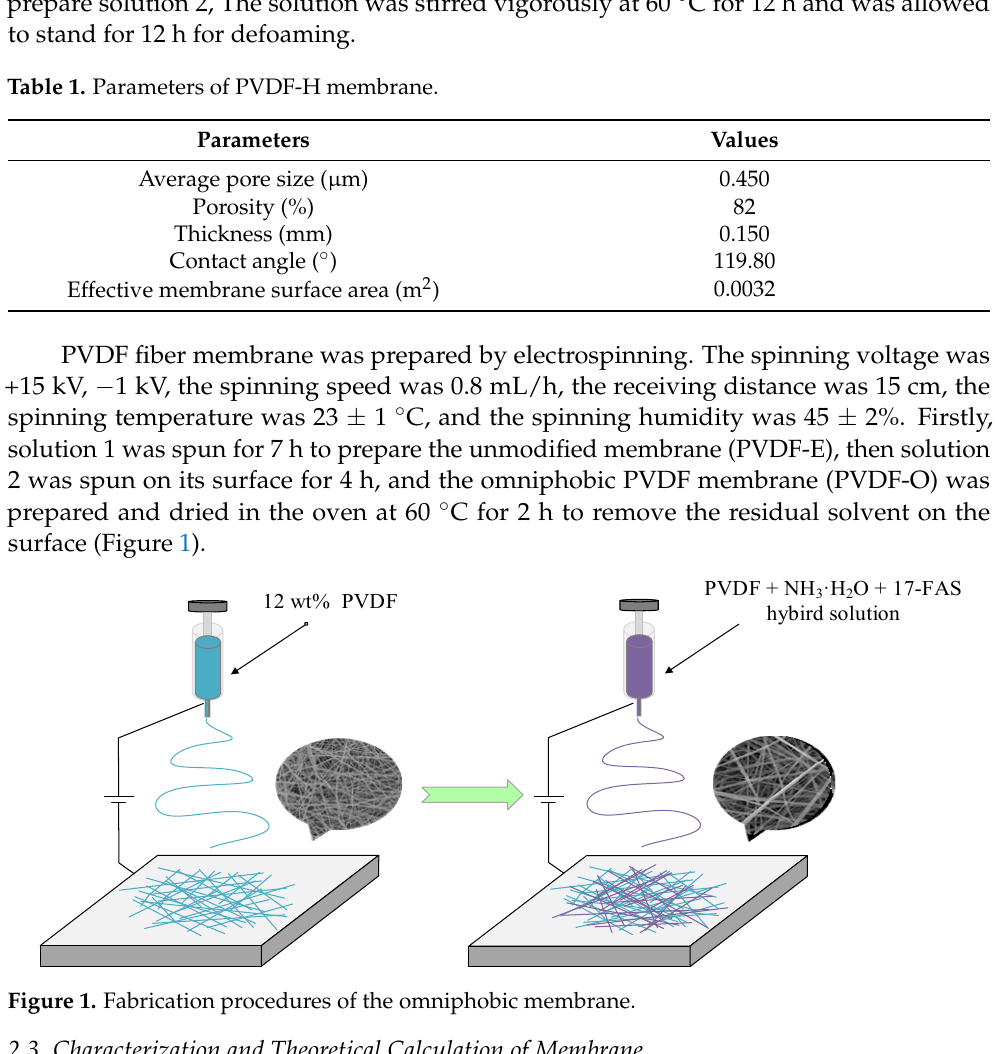
Table 1. Parameters of PVDF-H membrane.